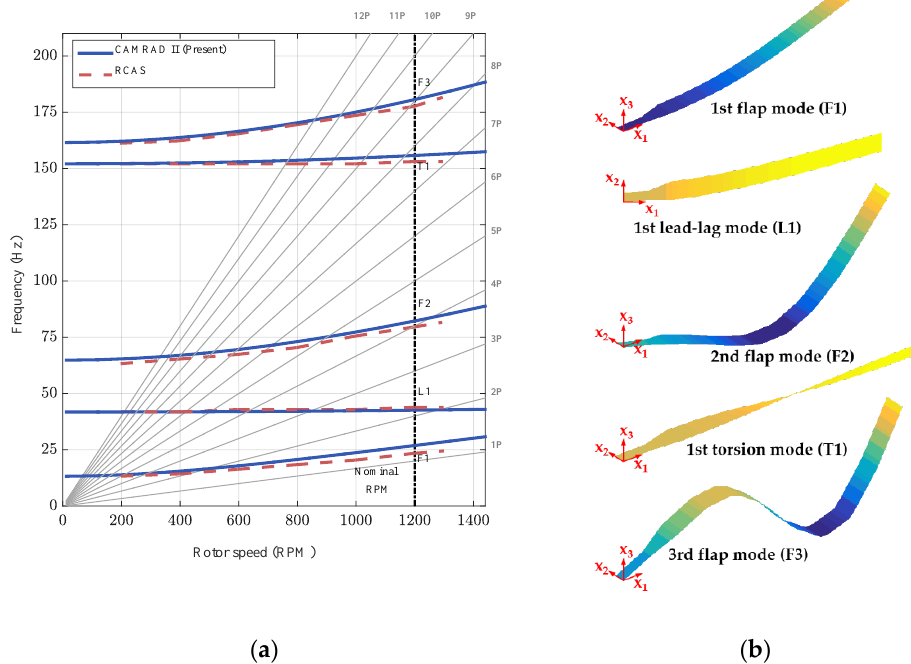
Figure 8. Validation for natural frequencies of rotating blade with RCAS [20]: ( a ) Fan plot; ( b ) mode shapes at the nonrotating condition.